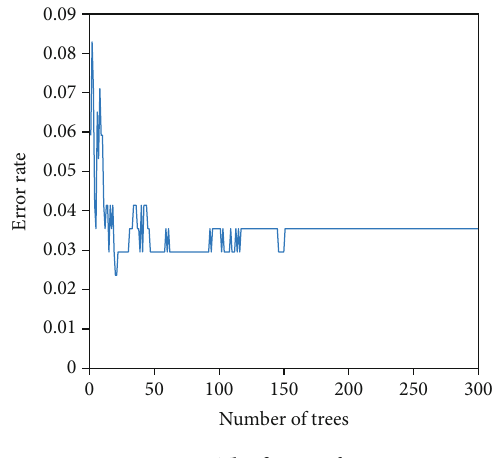
Figure 4: The fi tness of RF. Table 3: Generator feature data sets from SCADA